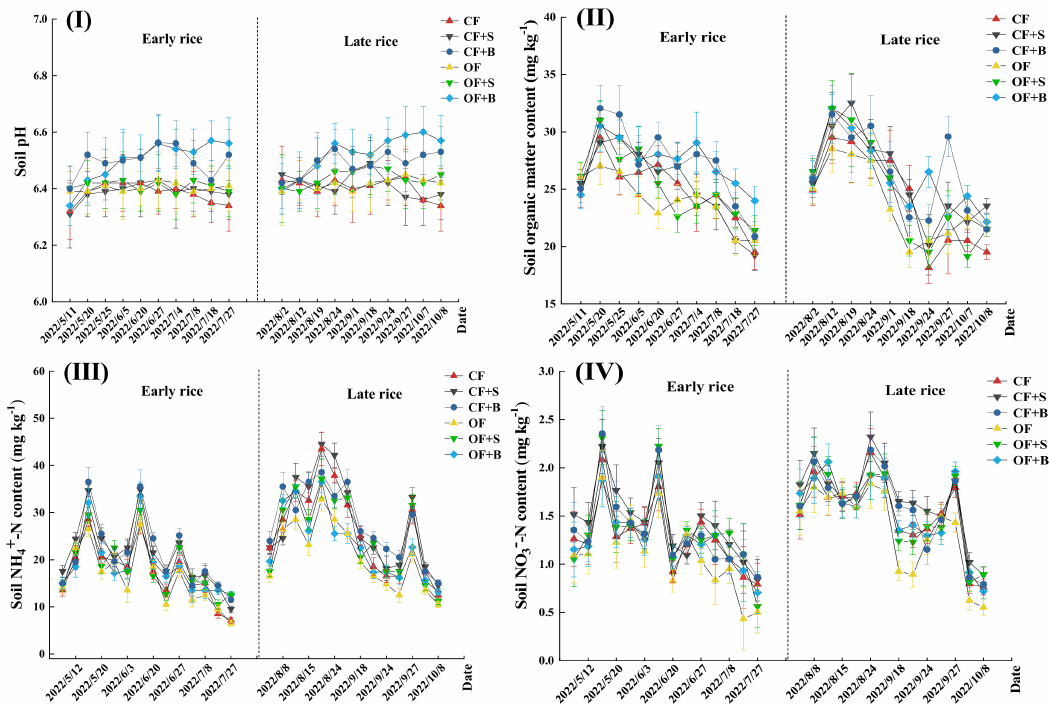
Figure 5. Effects of different treatments on the soil pH ( I ), soil organic matter content ( II ), soil NH 4+ -N content ( III ), and soil NO 3 − -N content ( IV ) in the double rice cropping system. Error bars represent standard deviations ( n =